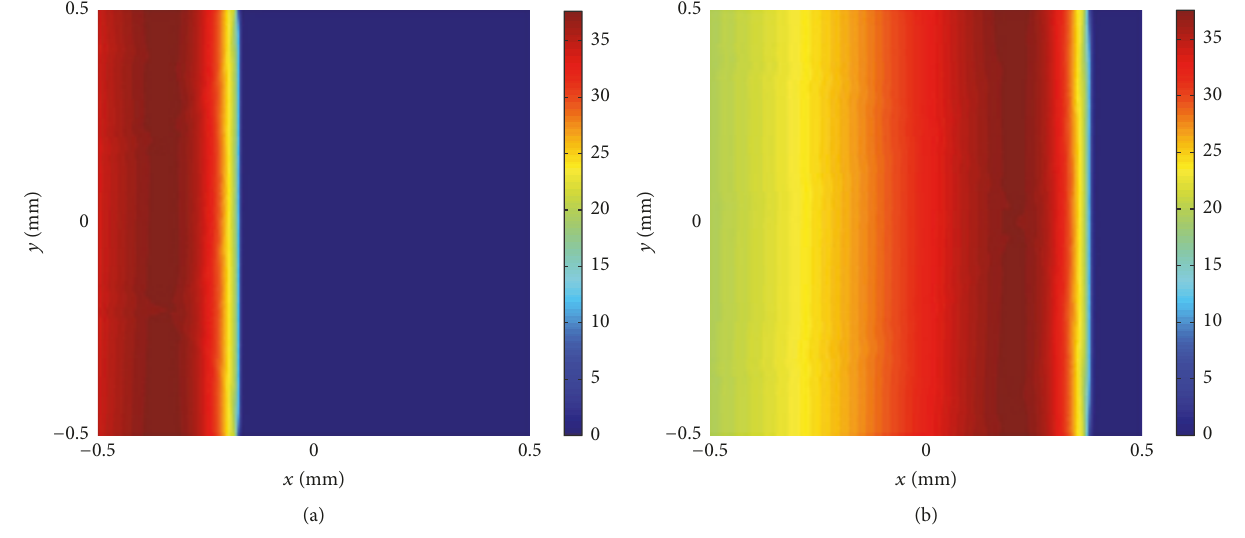
Figure 9: Pressure at 𝑡 = 1.2 𝜇 s and 3.2 𝜇 s for 𝜏 ℎ = 2𝜏 .